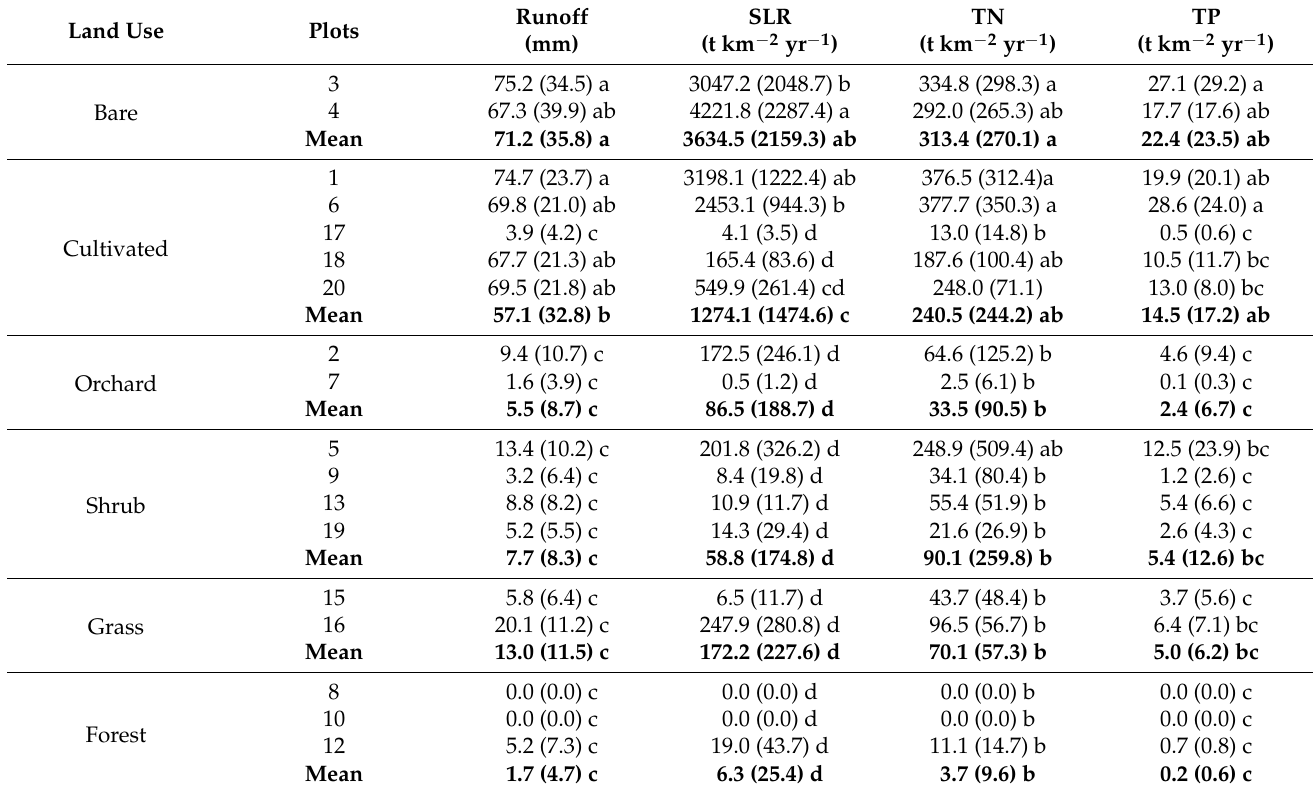
Table 3. Mean annual surface runoff, soil loss rate (SLR), and nutrient (TN and TP) losses from the plots in 2014–2019. The numbers in the bracket are standard deviations. Average values in the columns with the same letter were not significantly different at p = 0.05, as determined by Fisher’ protected least significant difference